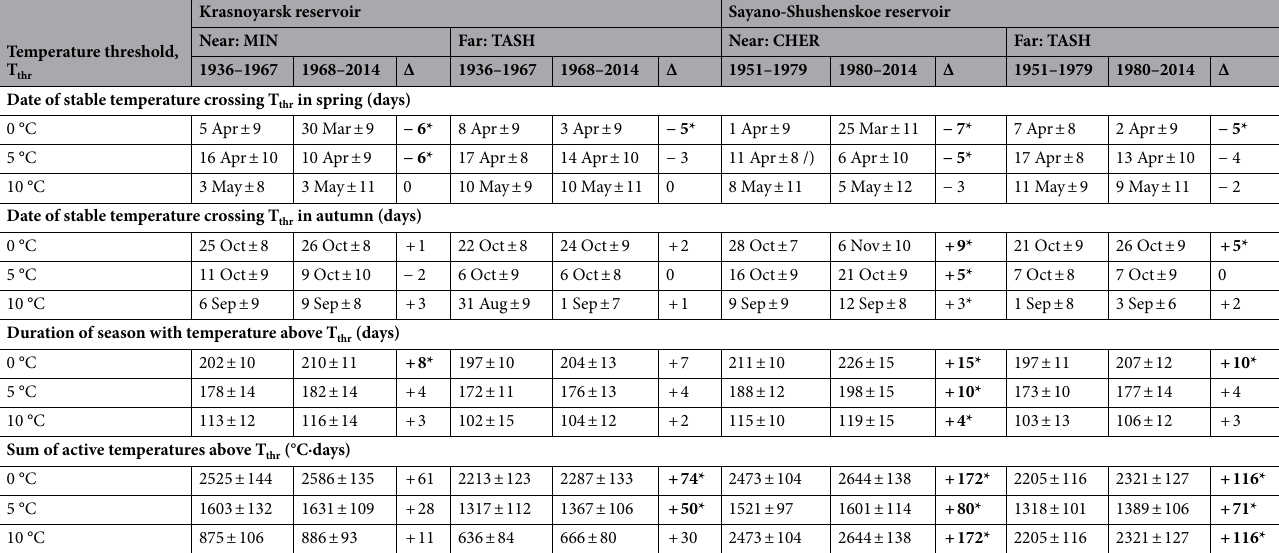
Table 3. Impact of the reservoirs on temperature variables. For each reservoir and station (Minusinsk—MIN, Cheryomushki—CHER, Tashtyp—TAH), the first two columns show mean ± standard deviation over sub- periods before to after launching of the turbines; the third column (Δ) shows difference in means between sub-periods, significant (p < 0.05) differences are written in